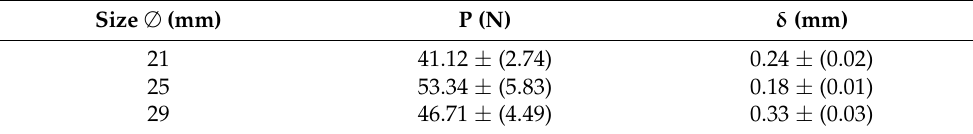
Table A3. Mean values of maximum load and corresponding displacement obtained through the